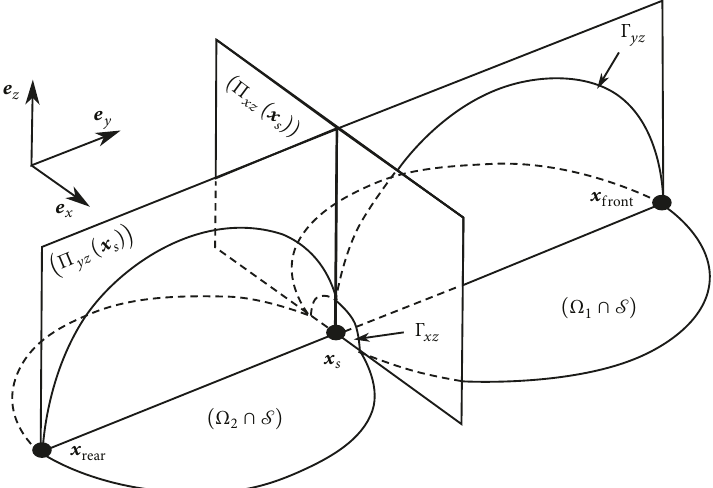
Figure 4: Illustration of the planes Π 𝛼𝑧 ( x 𝑠 ) , the corresponding boundary curves Γ 𝛼𝑧 (with 𝛼 = 𝑥 , 𝑦 ), and the location of the points x rear , x s , x ∈ ⋃ (Ω ∩ S ) front 𝑖 𝑖=1,2